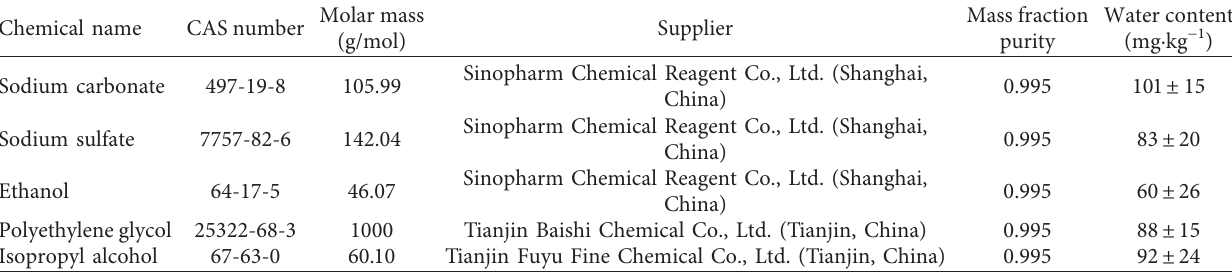
Table 1: The sources and purities of chemicals used in the